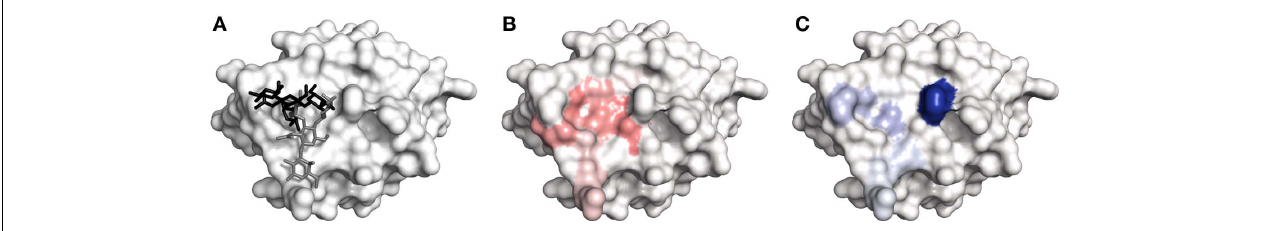
FIGURE 5 |The recognition of Gal β (1 → 4)[Fuc α (1 → 3)]GlcNAc β (1 → 3)Gal by DC-SIGN. (A) Comparison of crystal structure binding mode (PDB code 1SL5; black) with top ranked docked pose (gray). (B) Hydrogen bonding map. (C) van derWaals interaction map. Color depth corresponds to importance of the mapped residue for recognition. All figures generated in